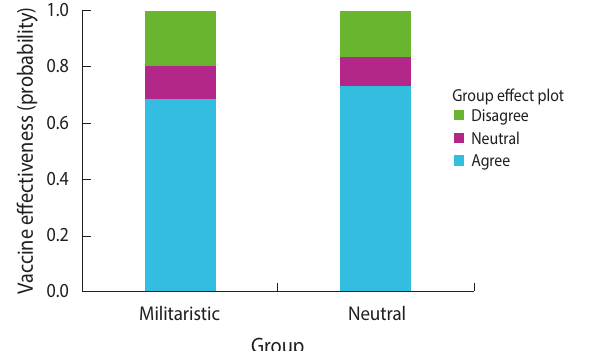
Figure 2. Probabilities of agreement regarding vaccine effective- ness.